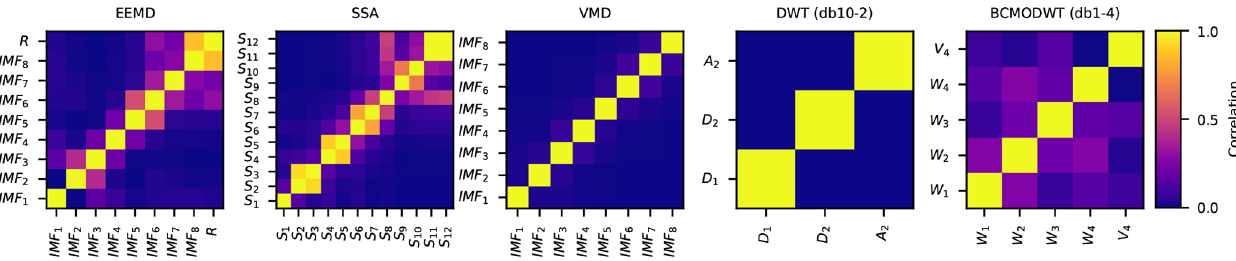
Figure 13. Absolute Pearson correlation coefficients of signal components obtained by different decomposition methods for the time-series data of the Huaxian station.